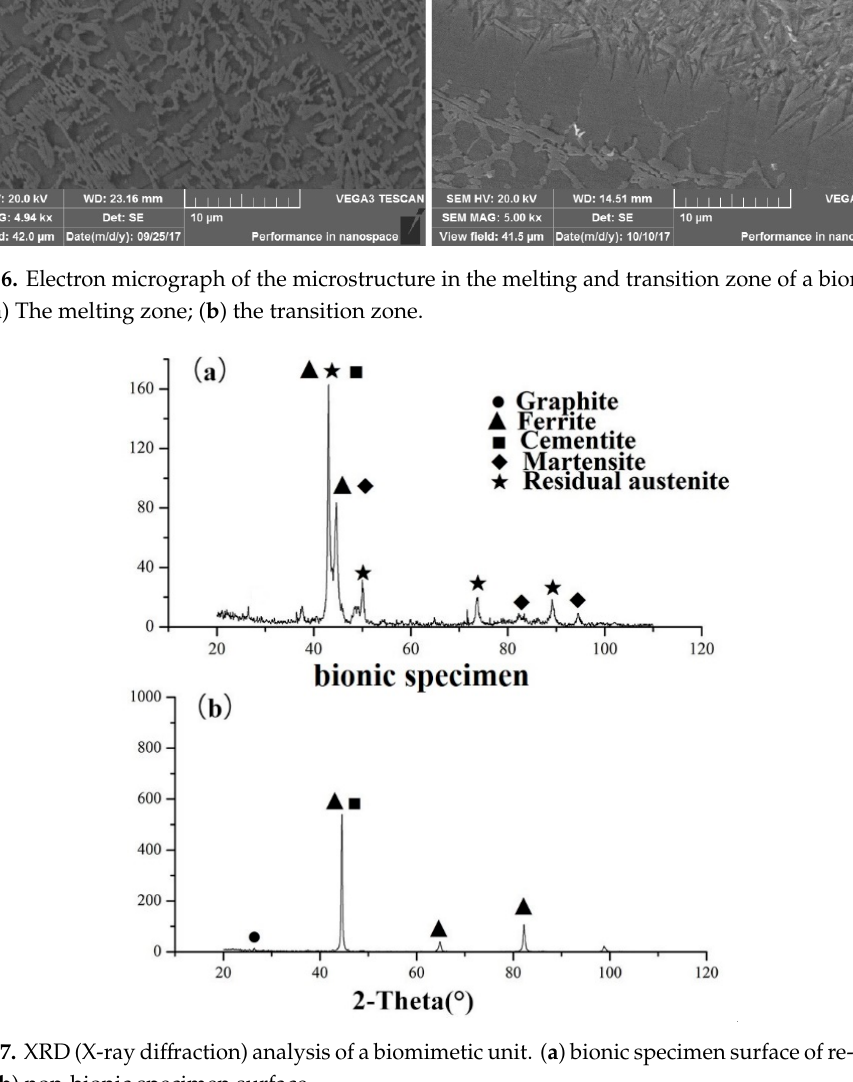
Figure 7. XRD (X-ray diffraction) analysis of a biomimetic unit. ( a ) bionic specimen surface of re-melting units; ( b ) non-bionic specimen surface .